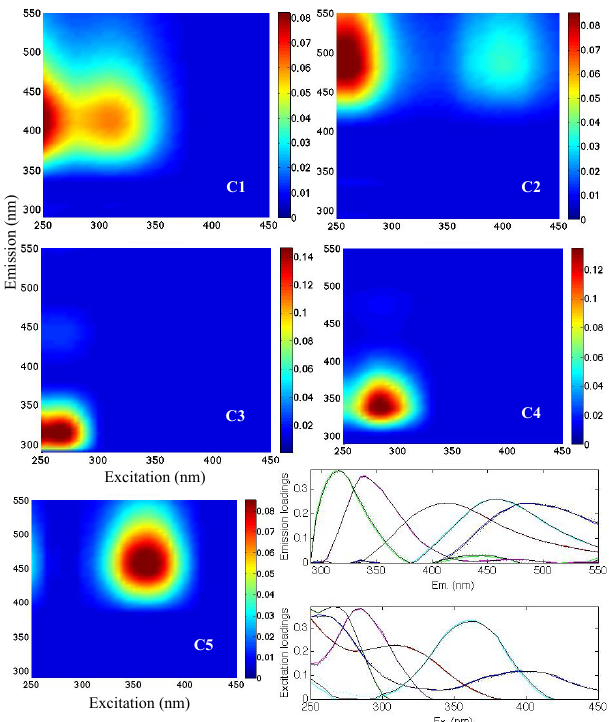
Figure 7. Spectral characteristics of the five fluorescent components (C1, C2, C3, C4, and C5) identified by PARAFAC. Figures show the EEMs plots of individual components in Raman Units (R.U.) of intensity. Excitation and emission loadings derived from the five- component PARAFAC model using split-half validation technique (bottom right). Dashed, colored solid and black lines represent the excitation and emission loadings of the two split halves and the whole data set, respectively. Positions of their maxima are given in Table 2.